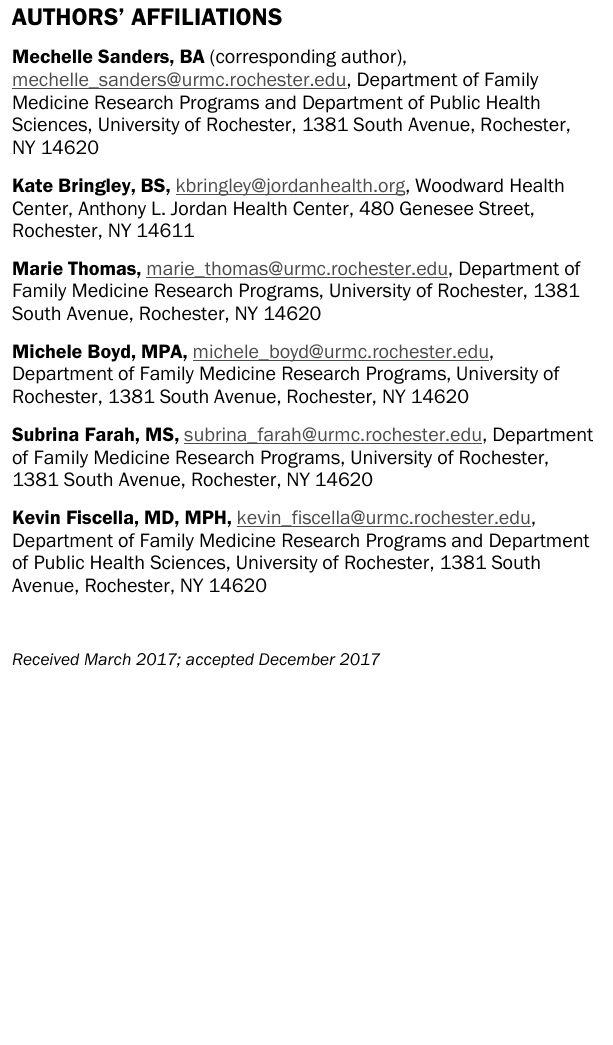
Table 2: Patient pre- and post-intervention survey results: demographics Table 4: Clinicians and nurse pre- and post- intervention survey